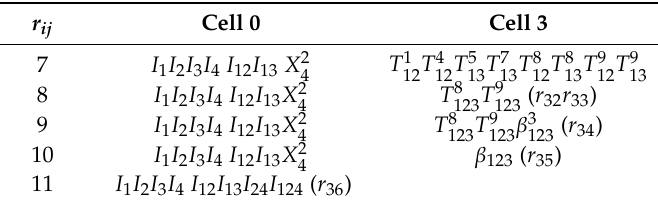
Table 5. Exploration process of frequent